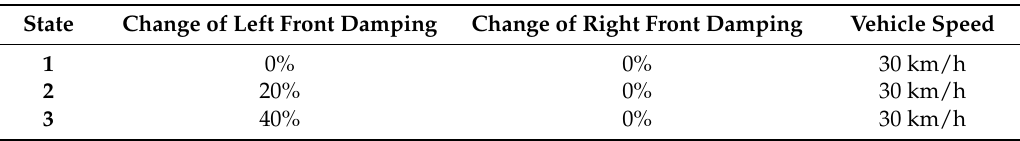
Table 6. Changes of damping in the test.